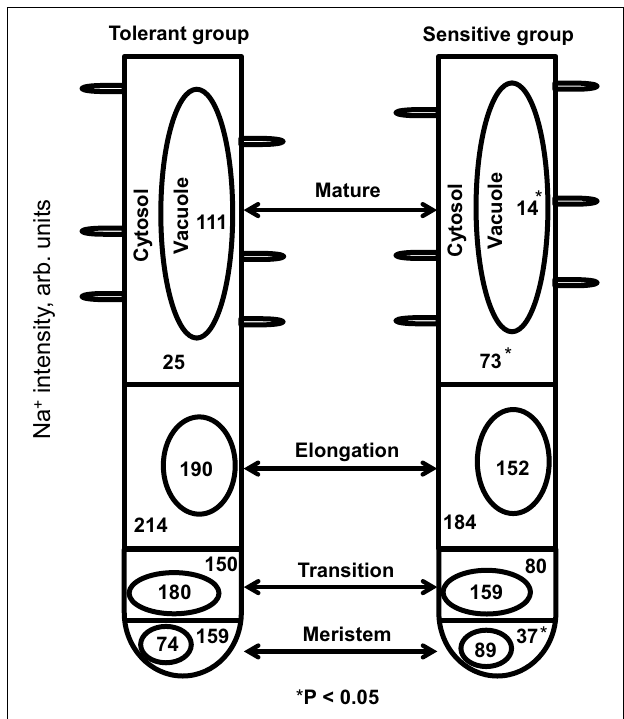
FIGURE 11 | A summary of Na + distribution between various intracellular compartments and functionally different root zones in bread wheat. Numbers represent mean pooled values for CoroNa Green fluorescence intensity (arbitrary units) for salt-sensitive and salt-tolerant clusters.